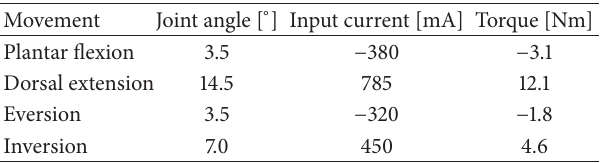
Table 1: Appropriate input current [mA] and resulting torque [Nm] for the requested joint